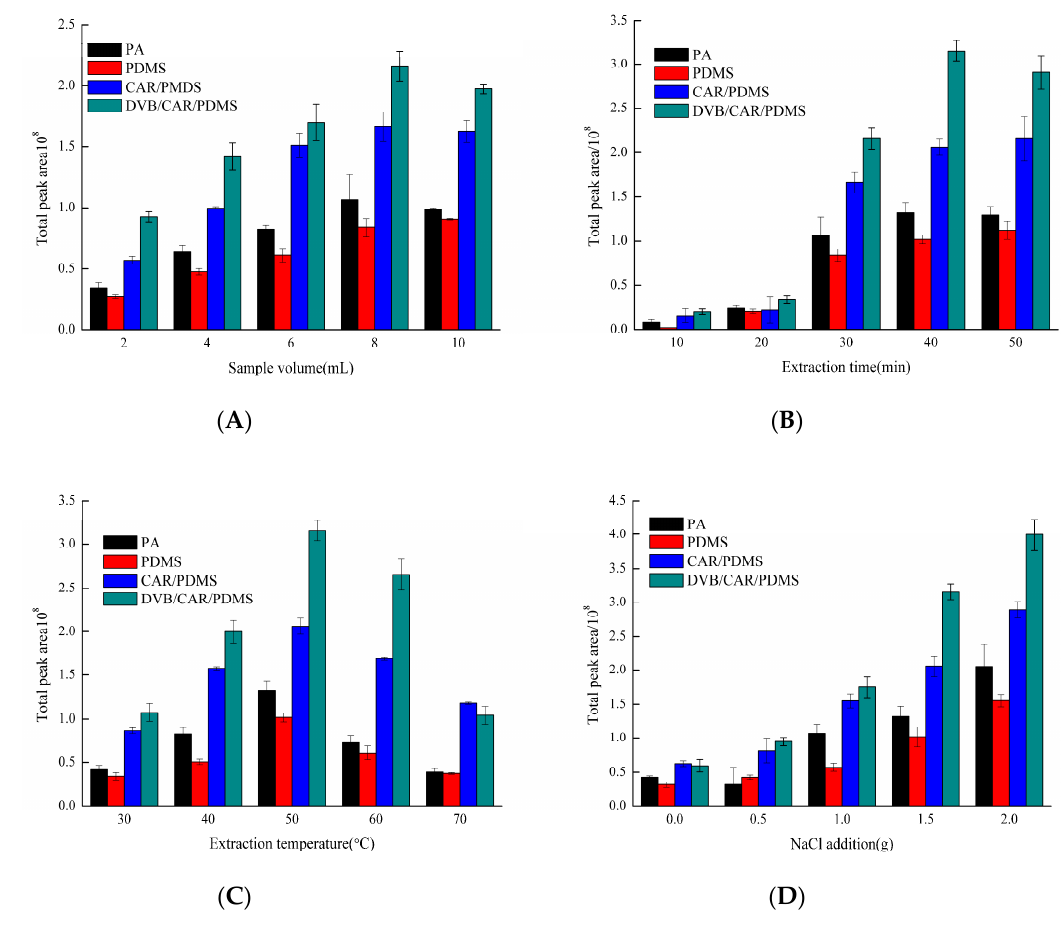
Figure 1. Effects of ( A ) sample volume, ( B ) extraction times, ( C ) extraction temperatures, and ( D ) NaCl addition on the extraction effects. ( A ) extraction time: 40 min, extraction temperature: 40 °C, NaCl: 1 g; ( B ) sample amount: 8 mL, extraction temperature: 40 °C, NaCl: 1 g; ( C ) sample amount: 8 mL, extraction time: 40 min, NaCl: 1 g; ( D ) sample volume: 8 mL, extraction time: 40 min, extraction temperature: 60 °C.